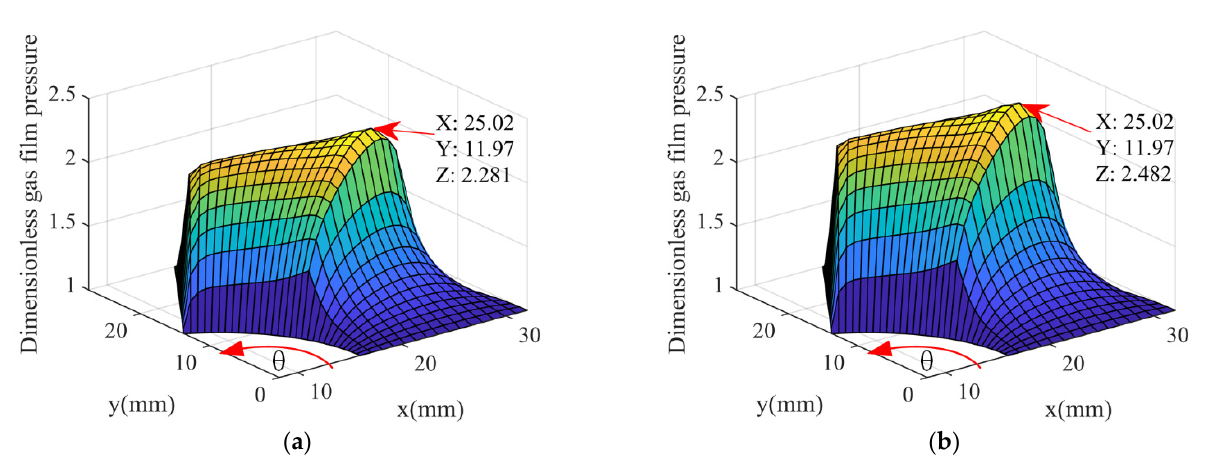
Figure 8. Deformation distribution of top foil under different thermal model. ( a ) Isothermal model; ( b ) THD model.